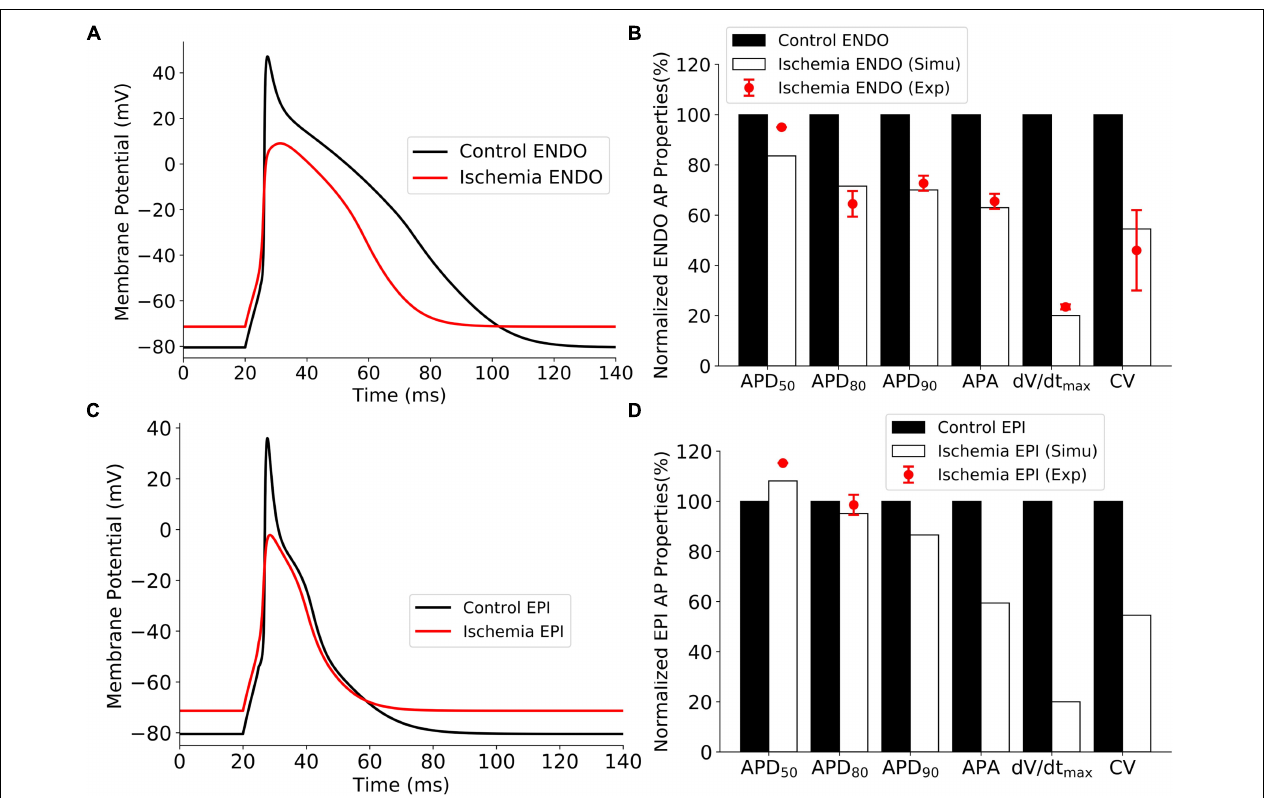
FIGURE 6 | Effect of ischemia on ventricular APs. (A) APs of endocardial myocytes for control and 10 min after the onset of ischemia. (B) Comparison of simulation and experimental data of AP characteristics for control and ischemic conditions for endocardial myocytes. (C) APs of epicardial myocytes for control 10 min after the onset of ischemia. (D) Comparison of simulation and experimental data of AP characteristics for control and ischemic conditions for epicardial myocytes. AP, action